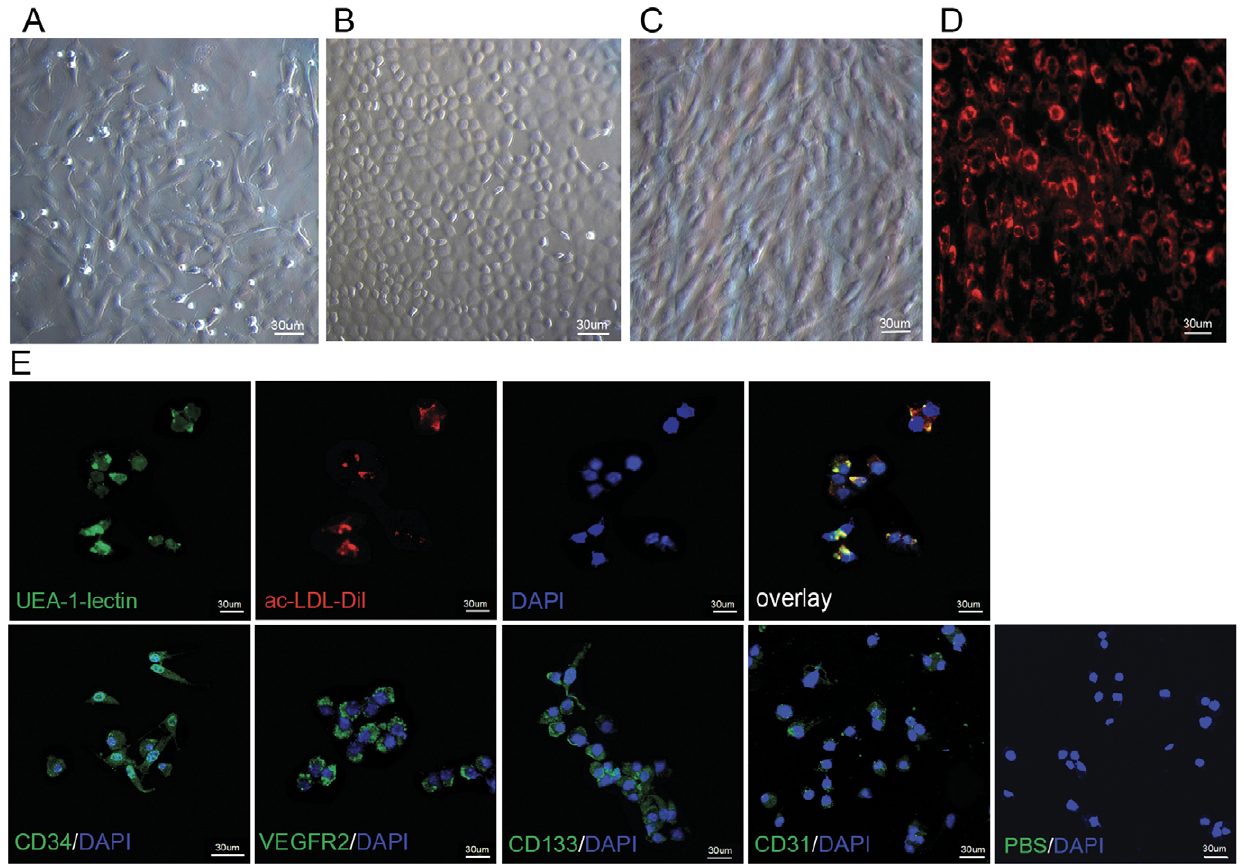
Figure 1. Cellular morphology of cultured EPCs. (A) The adherent cells showed irregular shape and began to form clusters 5 days after incubation. (B) A typical ‘‘cobblestone’’ appearance which is the characteristics of an endothelial cell monolayer was found at day 10. (C) Cells passaged 3 times at a ratio of 1:2 with an average of 7 days of growth showed homogenous spindle shaped morphology. (D) Fluorescence microscopy revealed the uptake of Conjugate 1 by adherent cells with positive rhodamine signals. (E) These cells were stained positively with FITC- UEA I, DiI-Ac-LDL and other endothelial progenitor cell markers, and showed low expression of endothelial cell marker CD31.